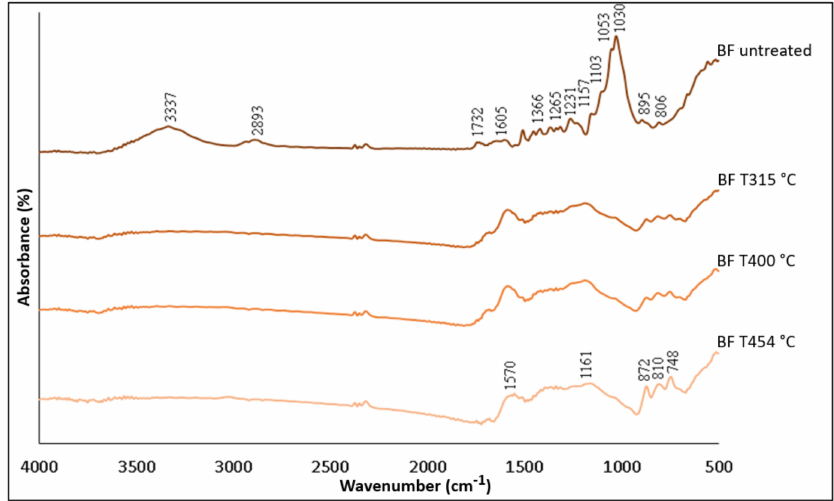
Figure 4. FTIR spectra of balsam fir pellets at different heat temperatures.